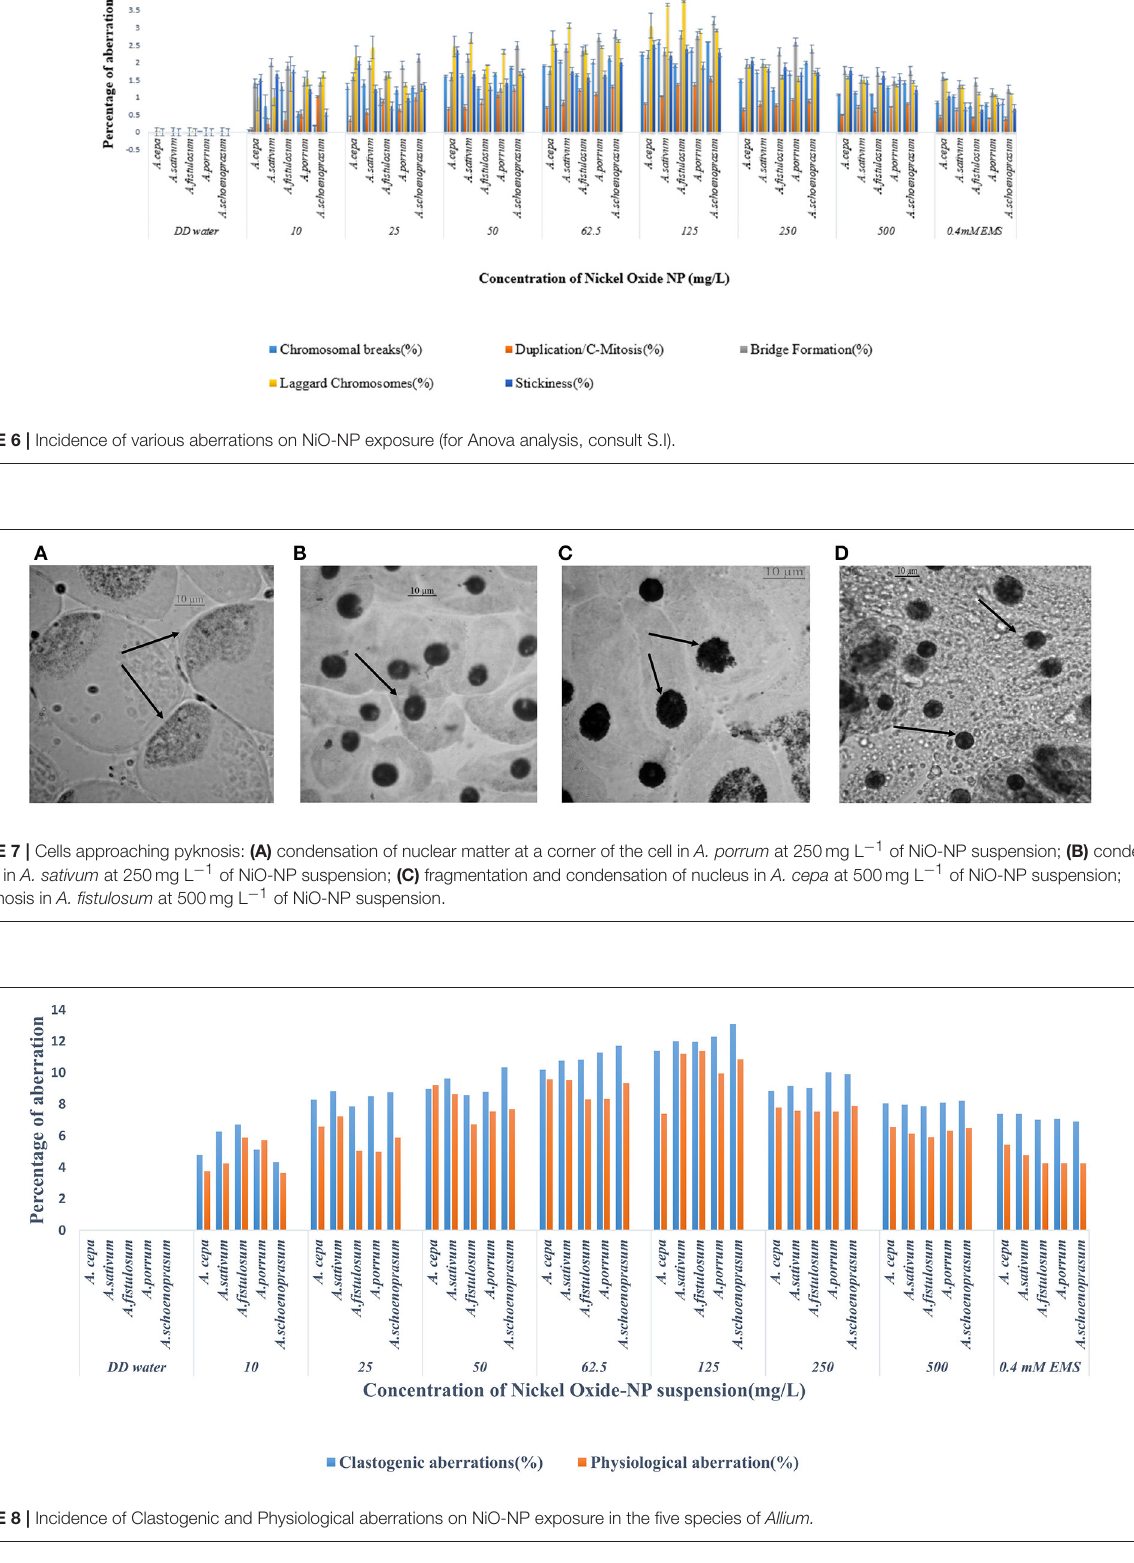
Frontiers in Chemistry |